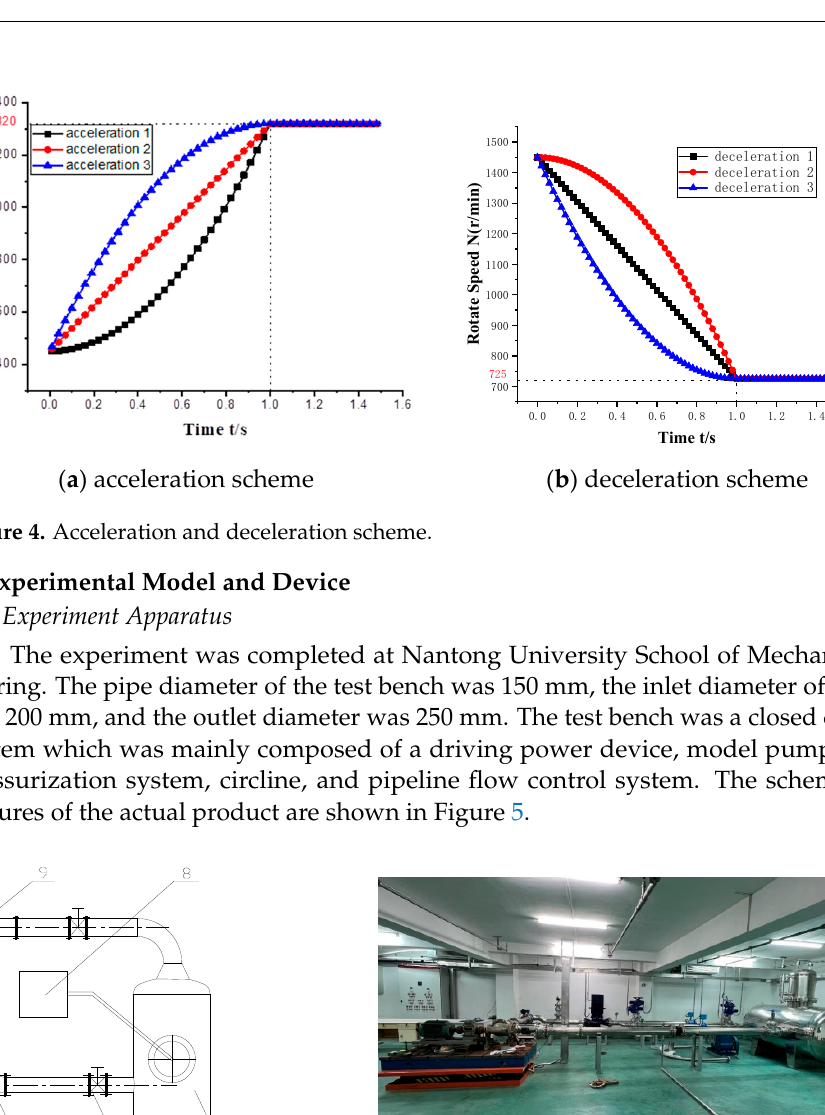
Figure 4. Acceleration and deceleration scheme.